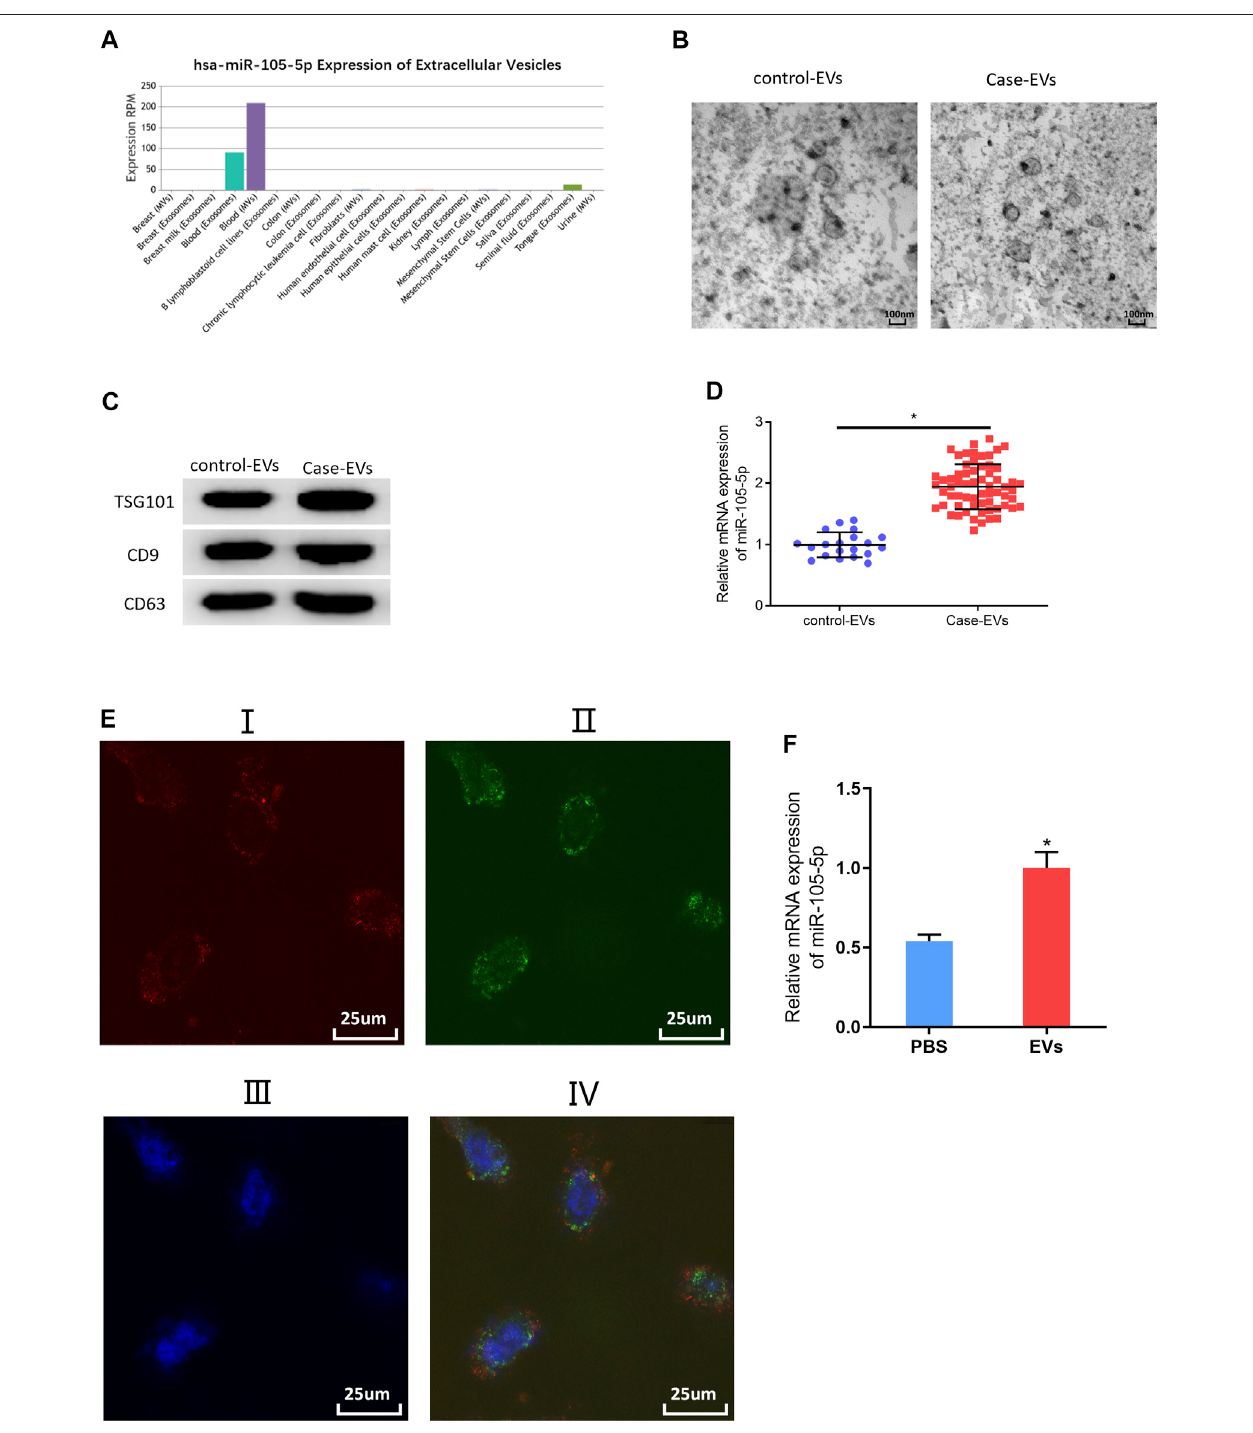
FIGURE6| MiRNA-105-5pinEVscanbetransferredtoESCCcells. (A) BarchartofmiRNA-105-5pexpressionindifferentexosomesormicrovesiclesdetectedby the EVmiRNA database; (B) Transmission electron microscope was used to observe the forms of serum EVs of ESCC patients and normal persons (ratio: 100 nm); (C) ProteinexpressionofEVsmarkersTSG101,CD9, andCD63inserum EVsofESCCpatients andnormalpersons; (D) MiRNA-105-5p expression inserum EVsofESCC patients and normal persons; (E) A fl uorescence microscope wasemployed to detect whether serum EVs of ESCC patients could be internalized by ESCC cells: I. Alex Fluro594 phalloidin-labeled F-actin (red fl uorescence); II. PKH67-labeled microvesicles (green fl uorescence); III. DAPI-labeled cell nuclei (blue fl uorescence); IV: Merge; Scale bar = 50 nm; (F) MiRNA-105-5p expression in ESCC cells after ESCC cells were co-cultured with serum EVs of ESCC patients. * p < 0.05.